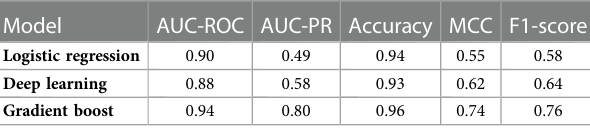
TABLE 2 Performance metrics for comparison of the three models.